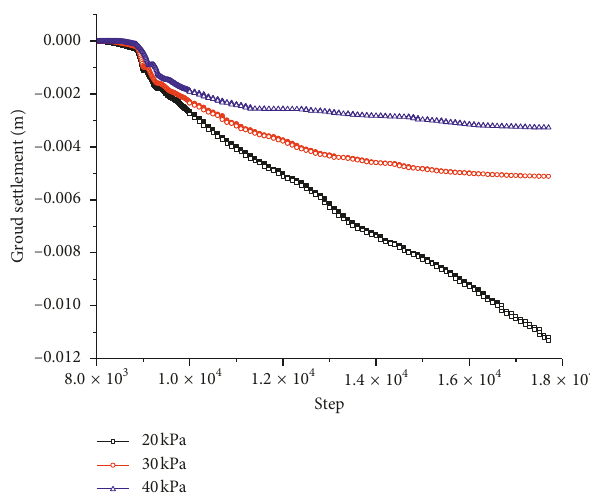
Figure 17: Surface subsidence under different support forces.